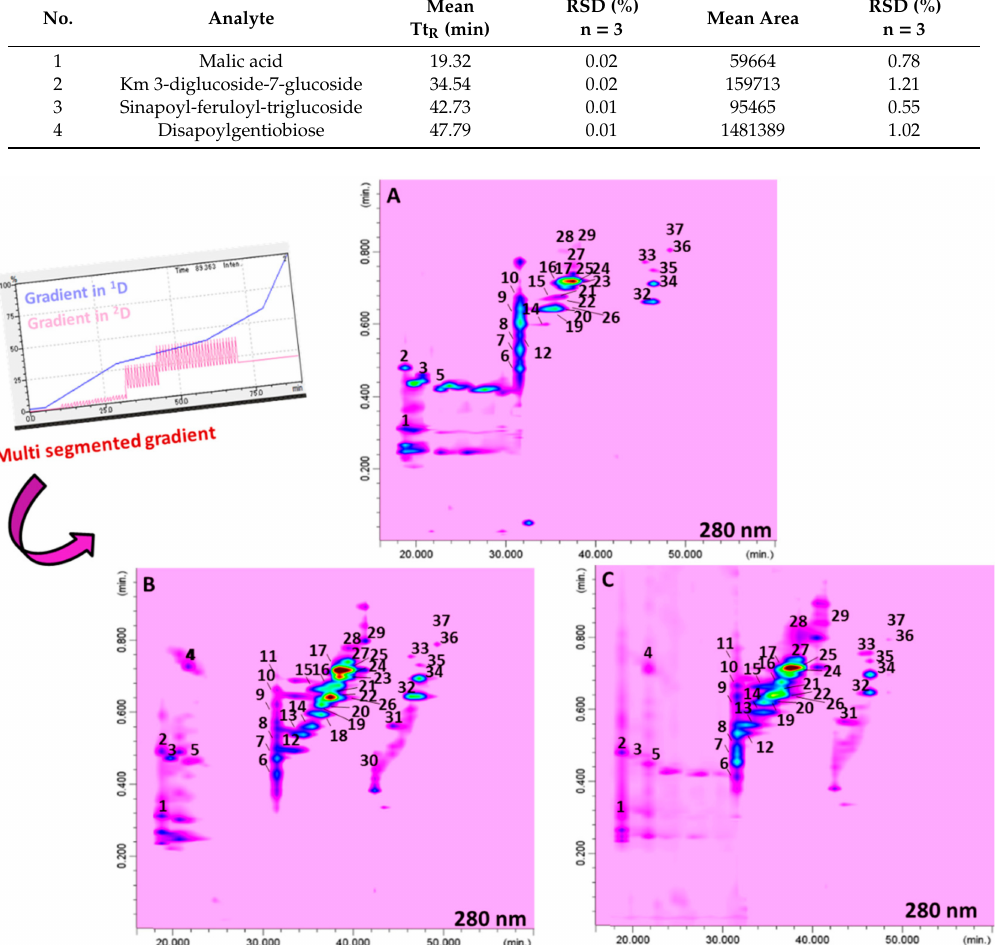
Figure 2. RP-LC × RP-LC contour plots of the system employed for ISCI Top ( A ), “Broad-leaf“ ( B ), and ISCI 99 ( C